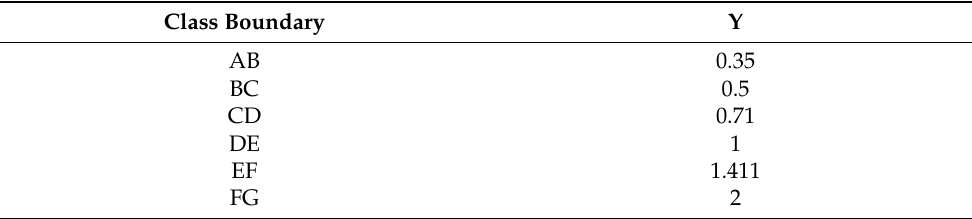
Table 5. Class boundaries for n ref = 4, Method 2. Class